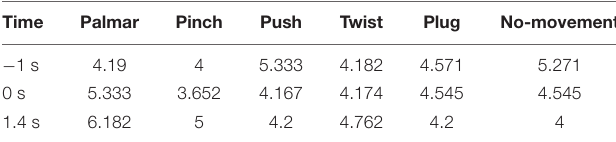
TABLE 2 | The average degree of network for each condition of S2.